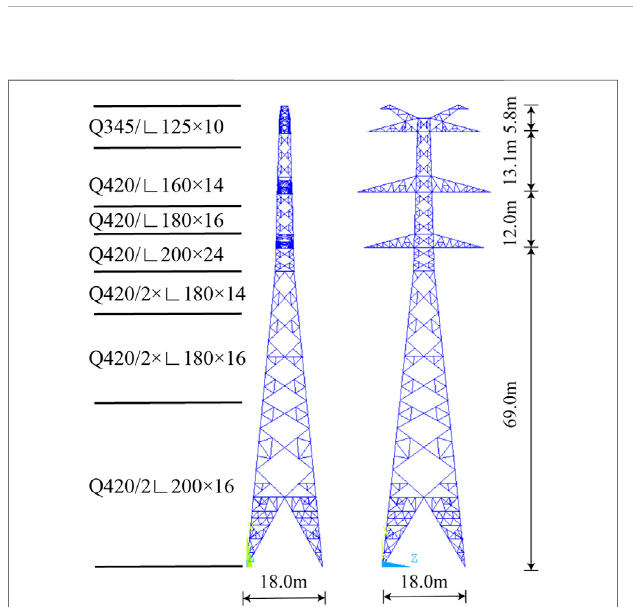
FIGURE 1 | Tower dimensions.